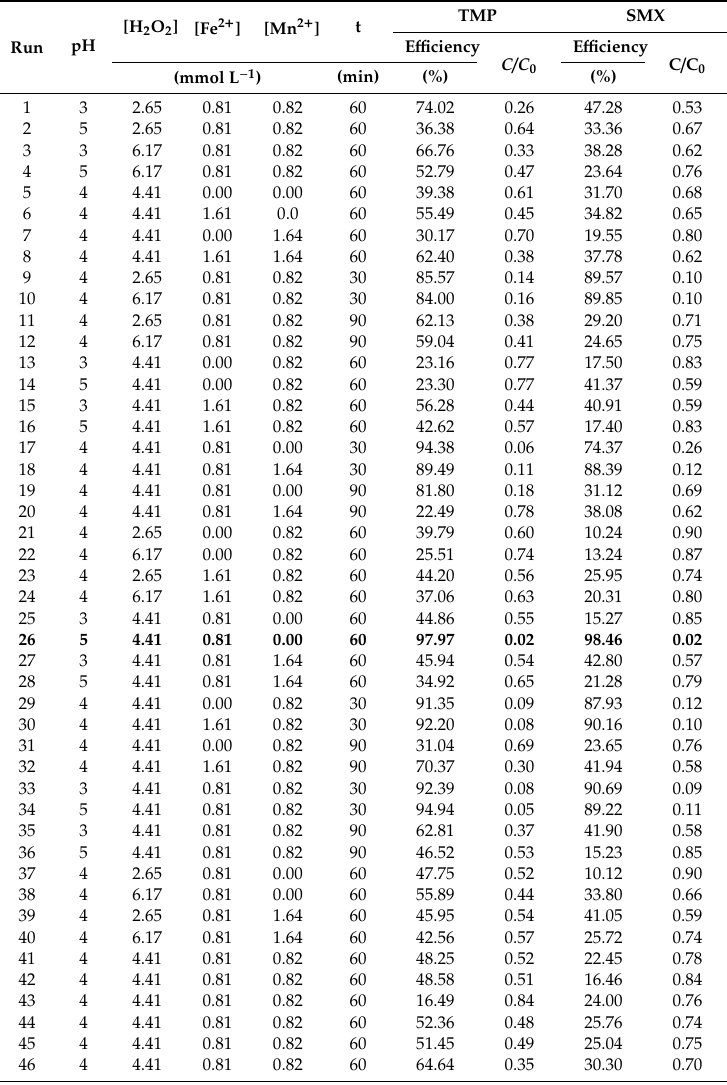
Table 2. Factors and levels from Box–Behnken design with their respective e ffi ciencies for degradation and relative concentrations using Fe 2 SO 4 · 7H 2 O (Fe 2 + ) as iron source and MnSO 4 · H 2 O (Mn 2 + ) as manganese source on the degradation of TMP and